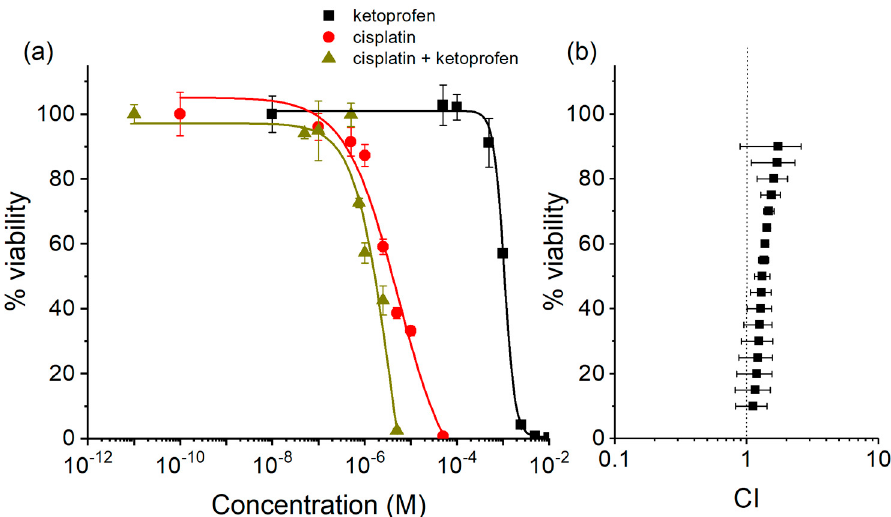
Figure 5. ( a ) Residual HCT 116 viability data and concentration response curves (four parameters logistic function) after 72 h of treatment of cisplatin (red circles), ketoprofen (black squares), and a mixture of cisplatin and ketoprofen (final cisplatin:ketoprofen ratio = 1:500, dark yellow triangles). Data are means ± SEM of at least three replicates. ( b ) Residual viability data for the 1:500 mix were used to obtain the Combination Index (CI) value by using the equation of Chou and Talalay for non-mutually exclusive drugs (see Materials and Methods).